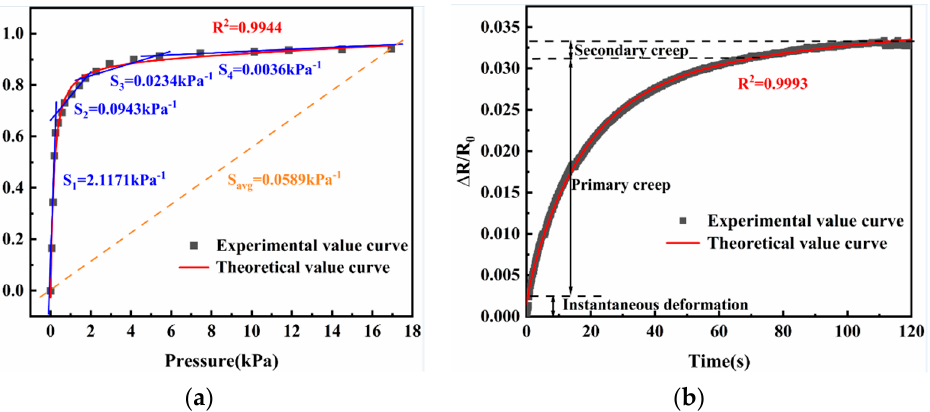
Figure 15. ( a ) Fitting curve and performance test for sensitivity and ( b ) fitting curve and performance test for creep.